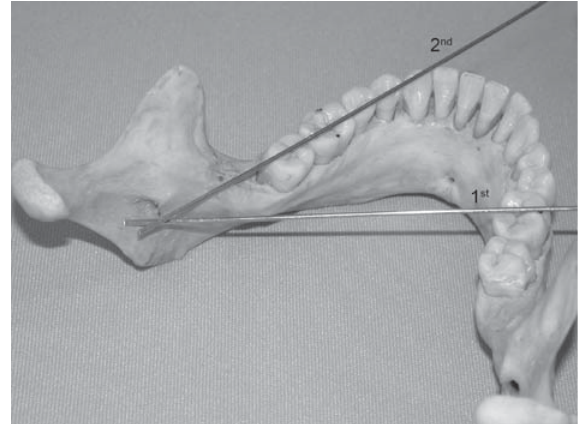
Figure 3- (cid:6)(cid:28)(cid:26)(cid:12)(cid:6)(cid:2)(cid:3)(cid:4)(cid:5)(cid:6)(cid:29)(cid:13)(cid:3)(cid:12)(cid:6)(cid:24)(cid:10)(cid:4)(cid:4)(cid:13)(cid:22)(cid:17)(cid:6)(cid:25)(cid:3)(cid:8)(cid:7)(cid:6)(cid:5)(cid:26)(cid:12)(cid:6)(cid:7)(cid:12)(cid:4)(cid:13)(cid:8)(cid:14)(cid:15)(cid:16)(cid:16)(cid:10)(cid:9)(cid:6) groove and the middle point of the slope of the distolingual cusp (or distolingual angle line) (note Figure 1) of the (cid:7)(cid:10)(cid:22)(cid:23)(cid:13)(cid:14)(cid:15)(cid:9)(cid:10)(cid:3)(cid:6)(cid:2)(cid:3)(cid:4)(cid:5)(cid:6)(cid:7)(cid:8)(cid:9)(cid:10)(cid:3)(cid:6)(cid:24)(cid:12)(cid:3)(cid:7)(cid:10)(cid:22)(cid:12)(cid:22)(cid:5)(cid:30)(cid:6)(cid:10)(cid:22)(cid:23)(cid:6)(cid:5)(cid:26)(cid:12)(cid:6)(cid:4)(cid:12)(cid:16)(cid:8)(cid:22)(cid:23)(cid:6)(cid:29)(cid:13)(cid:3)(cid:12)(cid:6) passing from the left side occlusal